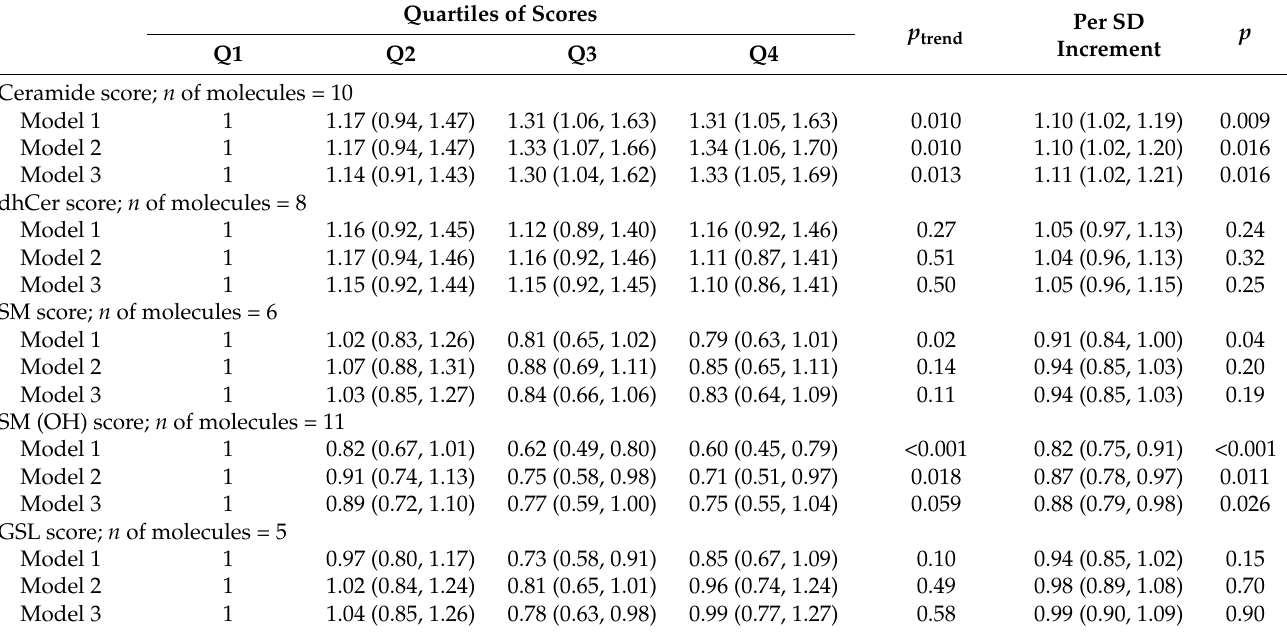
Table 3. Association between baseline sphingolipid scores and incident metabolic